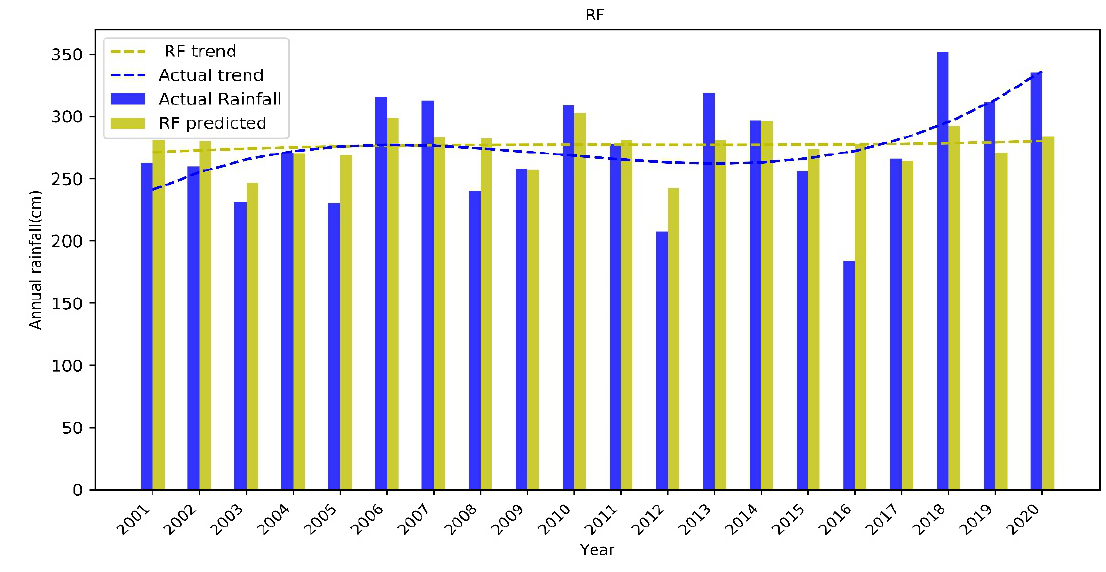
Figure 6. Bar plot of the predicted and observed annual rainfall for random forest regression model.